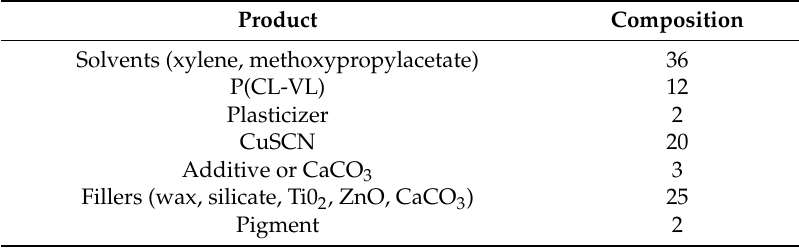
Table 3. Composition of paints (in wt